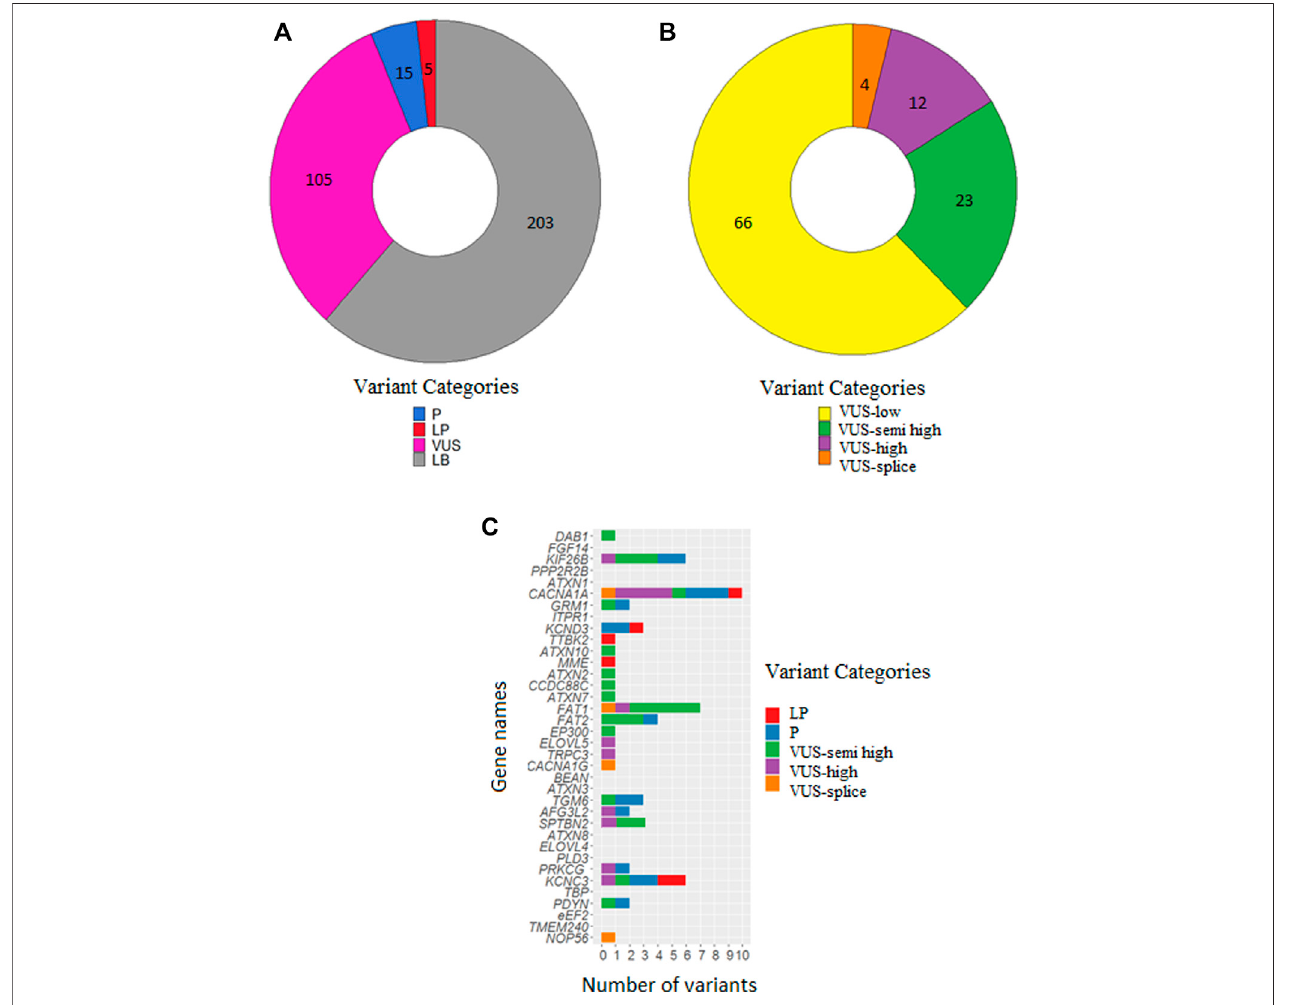
FIGURE 1 | Numbers of classi fi ed variants in 348 SCA patients. (A) Number of variants classi fi ed as P, LP, VUS and LB. (B) Number of VUSes classi fi ed as VUS- low, VUS-semi high, VUS-high and VUS-splice. (C) Distribution of P/LP variants, VUS-semi high, VUS-high and VUS-splice over the 36 SCA genes. The list is sorted on gene size with the largest on top ( DAB1 : 1,551,957 bases) and the smallest on bottom ( NOP56 : 5,801 bases).